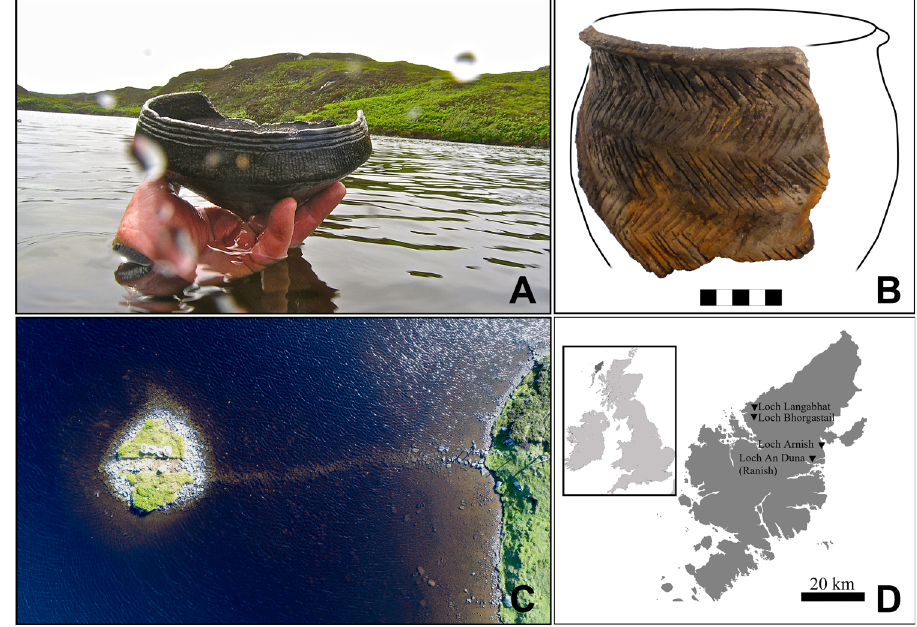
Fig. 1 | Pottery and sites investigated in this study. Photographs of an ‘ Unstan ’ typebowlrecovered from the lake bedatLoch Arnish ( A ),largeceramic sherdand reconstruction of a ridged baggy jar from Loch Langabhat ( B ), aerial view of the islet of Loch Bhorgastail and its associated causeway ( C ) and map of the Isle of Lewis in the Outer Hebrides showing the locations of the four Neolithic crannogs